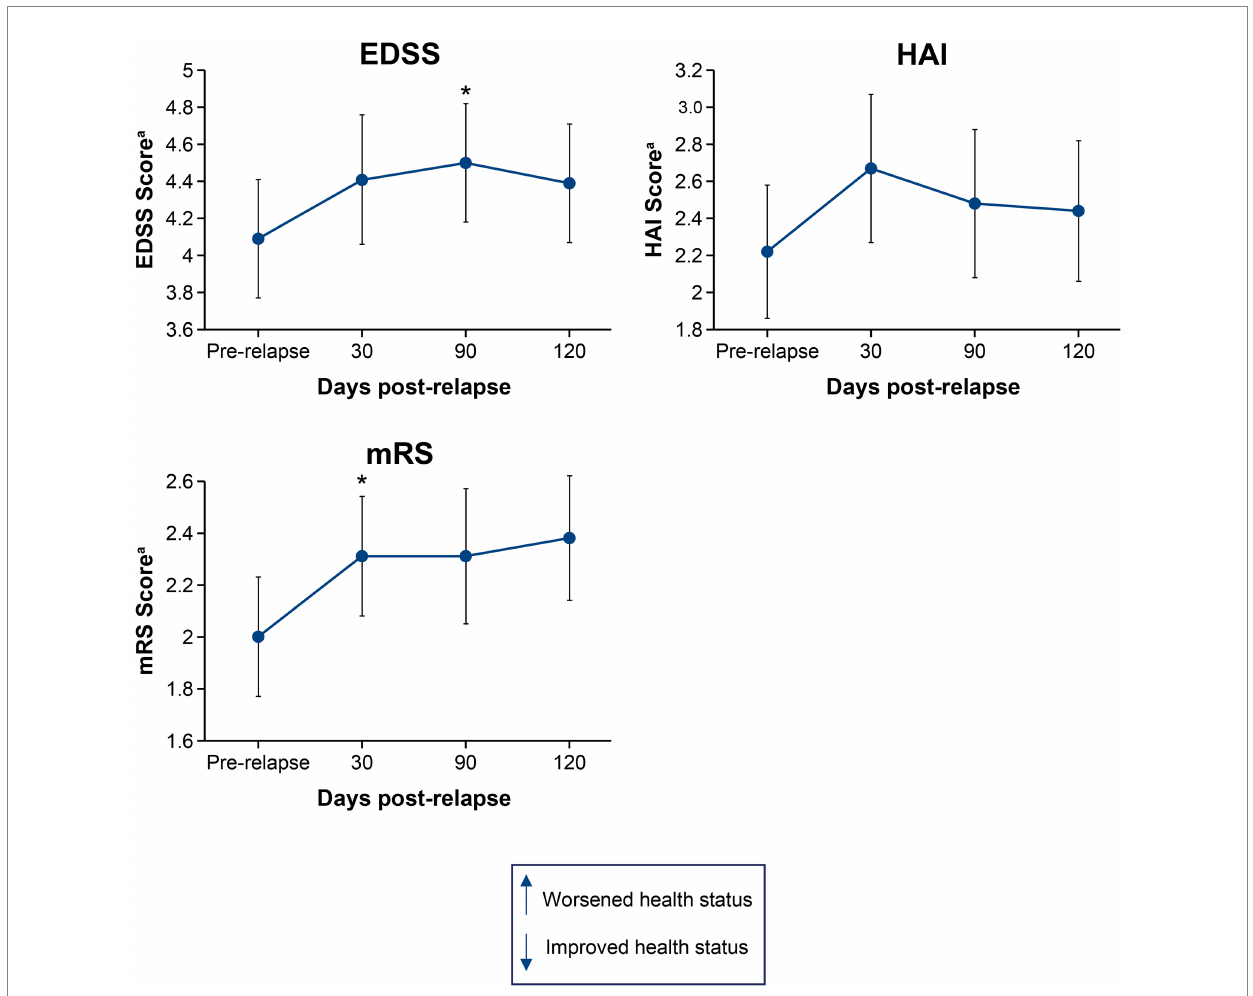
FIGURE 1 Mean change in EDSS, HAI, and mRS scores from pre-relapse to 30, 90, and 120 days post-relapse. * p < 0.05 for the mean change from pre-relapse to post-relapse. a Higher scores indicate worsened health status. EDSS, Expanded Disability Status Scale; HAI, Hauser Ambulation Index; mRS, modified Rankin